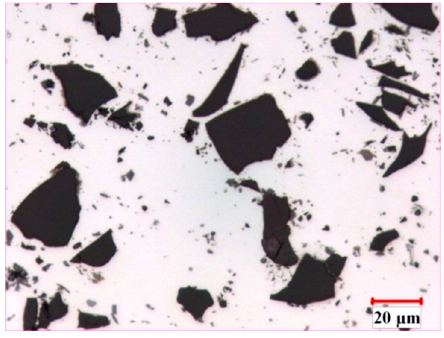
Figure 1. Optical micrograph of hot-rolled AA1100-16 vol.% B 4 C composites.